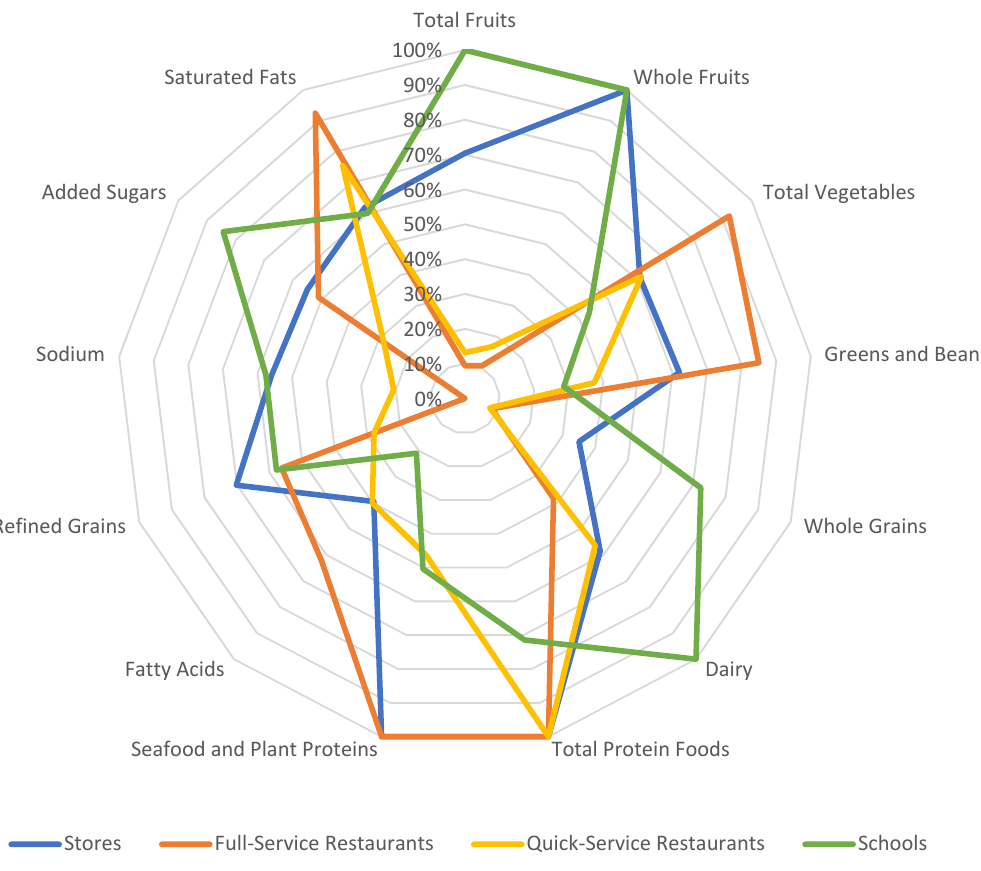
Figure 2. Differences in HEI-2015 component scores between types of food outlets in 2017–2018.